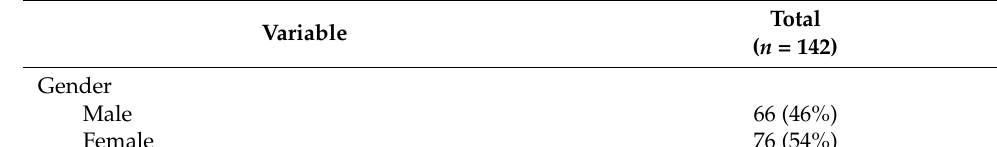
Table 1. Characteristics of the respondents participating in